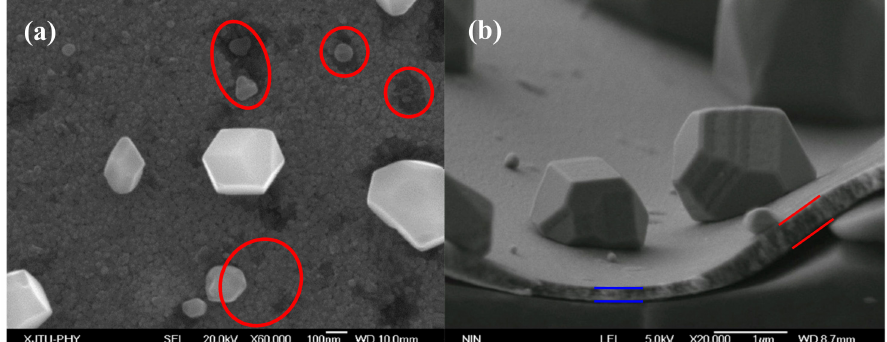
Figure 8. The surface and cross-sectional morphologies of the annealed Cu–Zr films. ( a ), the Cu atoms consumed, leaving some “shallow pits” on the alloy film surface, ( b ) the cross-sectional morphology of